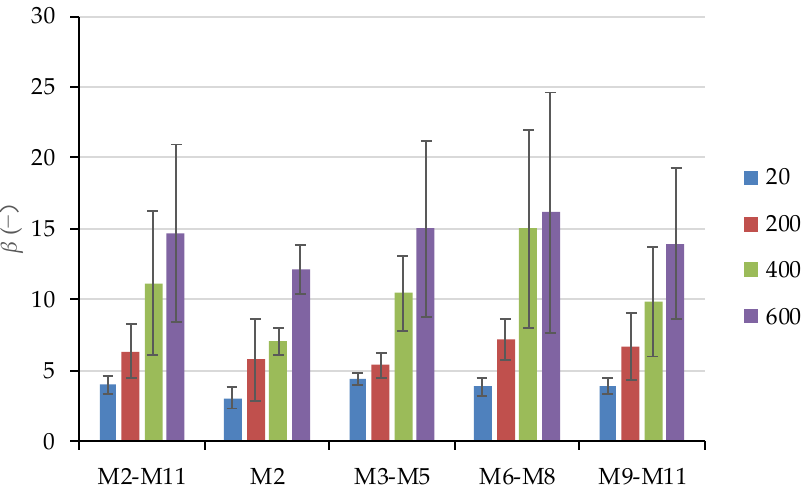
Figure 18. Parameter β determined by regression analysis to experimentally determine stress– strain relationships.